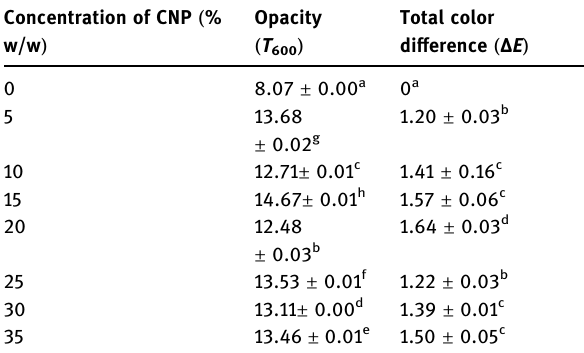
Table 3: Optical properties of starch/CNP fi lms Concentration of CNP ( %